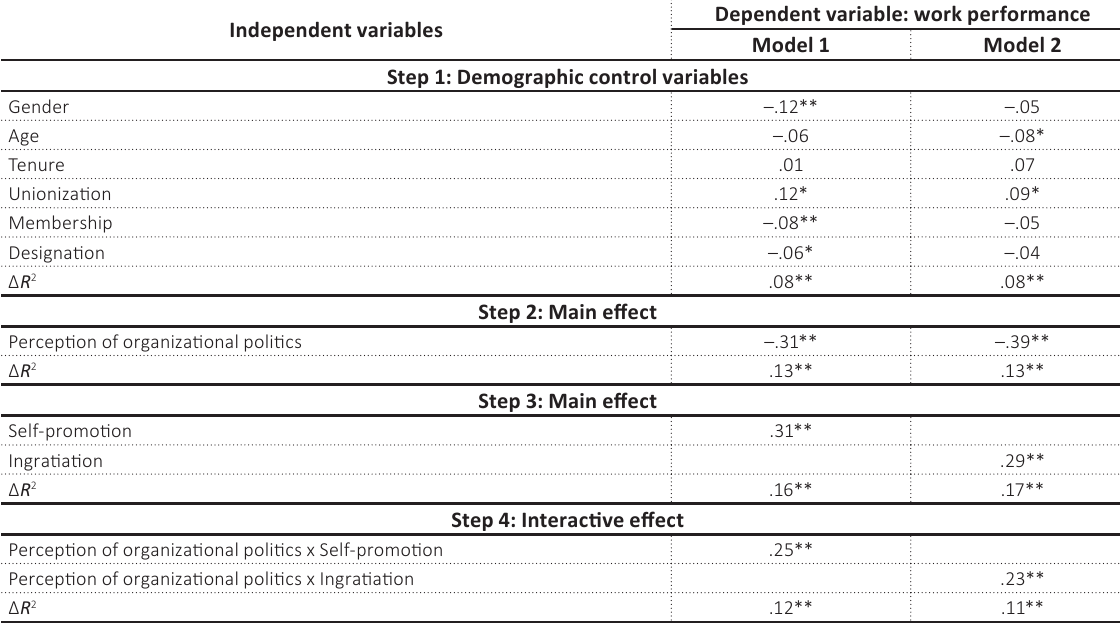
Table 1. Regression result testing direct and moderating effects: association of perception of organizational politics, self-promotion, and ingratiation with work